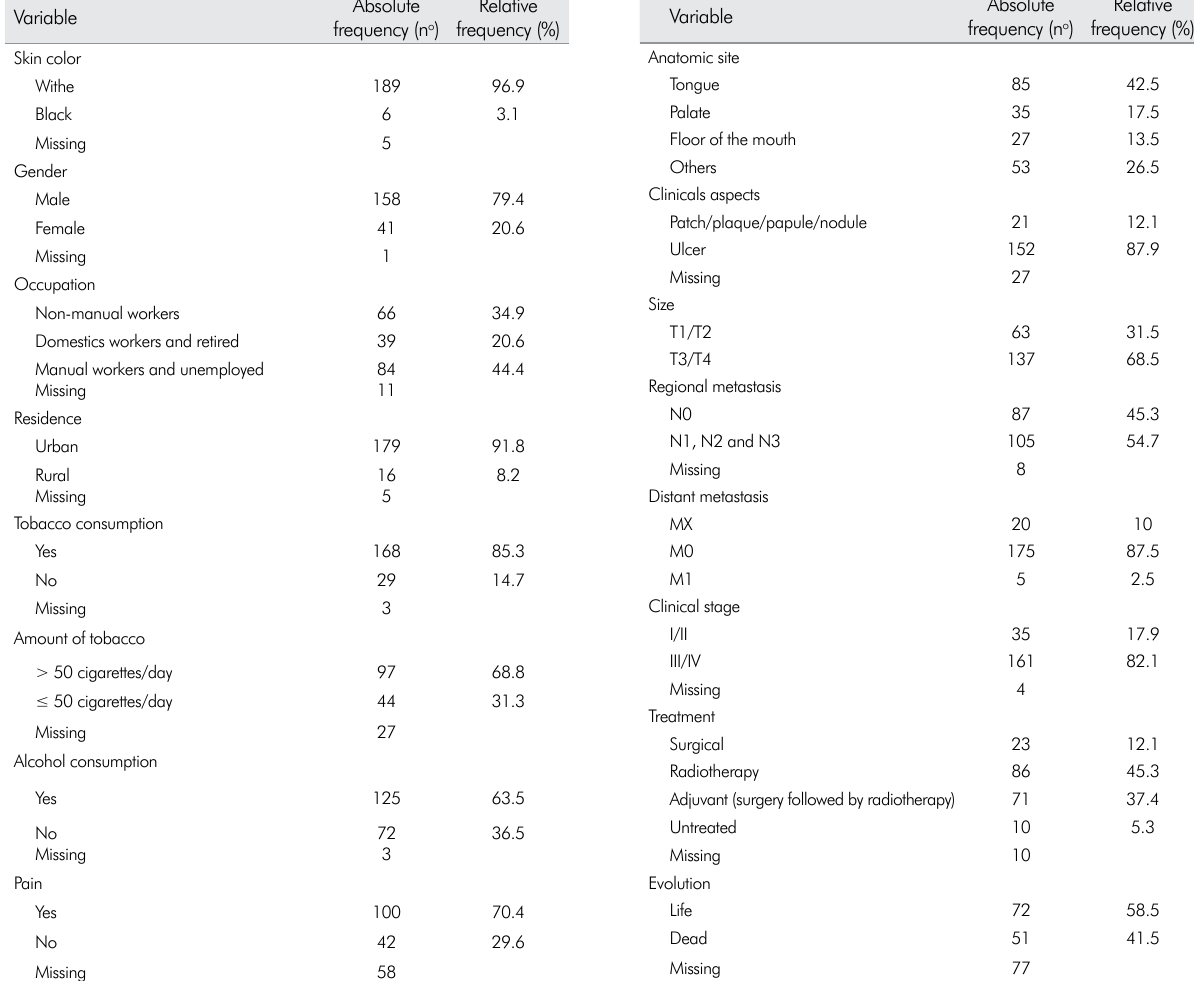
Table 1. Descriptive analysis of individual variables and lesion characteristics of patients with oral squamous cell carcinoma. (N = 200) Variable